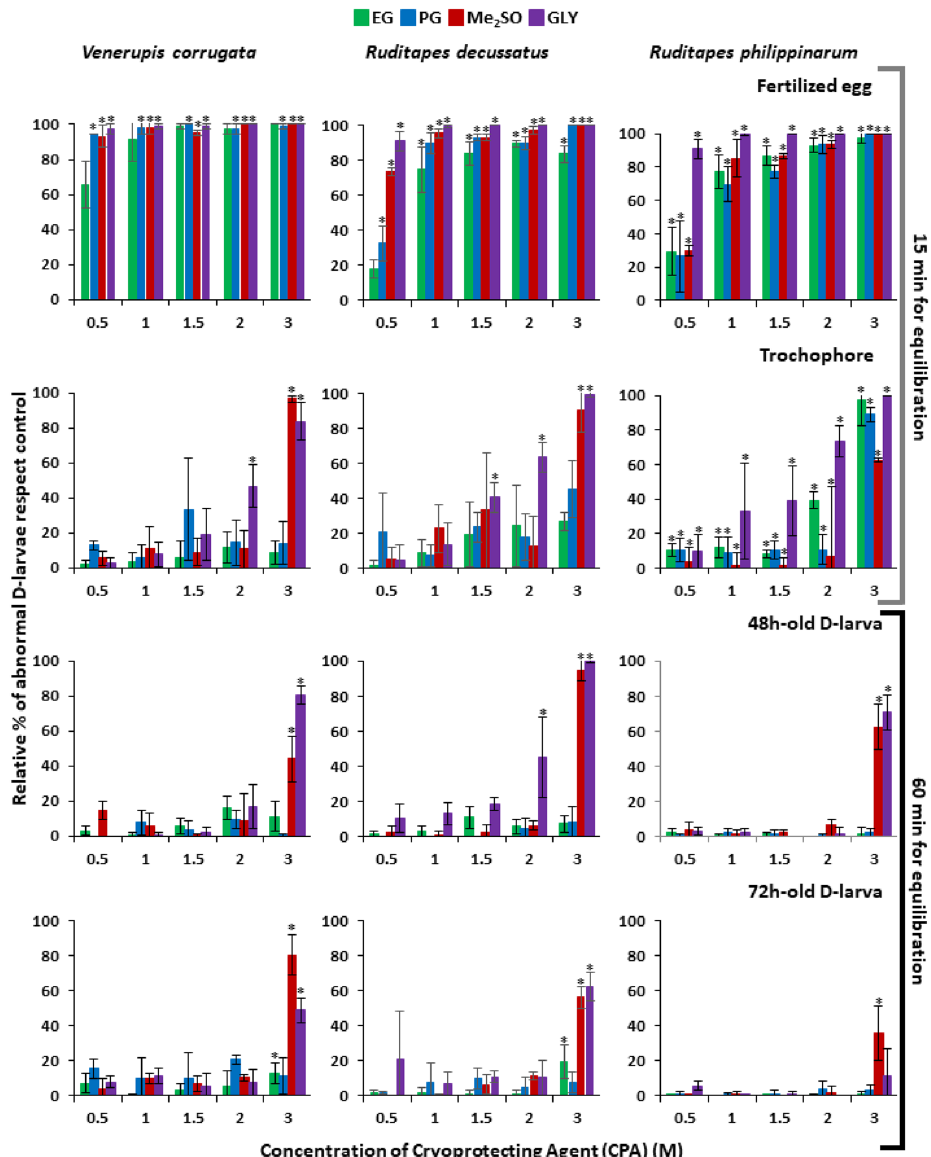
Figure 3. Percentage of abnormal D-larvae compared to control group developed from development stages of Venerupis corrugata, Ruditapes decussatus and Ruditapes philippinarum (fertilized egg, trochophore, 48 and 72 h-old D-larva) exposed to increasing concentrations of ethylene–glycol (EG), propylene-glycol (PG), dymethil-sulfoxide (Me 2 SO) and glycerol (GLY) . Results are expressed as mean ± standard deviation (SD), n = 3. Asterisk shows statistical differences with control assessments (p ˂ 0.05). This parameter has been calculated as the division between the percentage of abnormal D-larvae calculated divided by the abnormality percentage showed in controls. Abnormality in controls was in general below 25% and the average percentage of abnormality was 16 ±